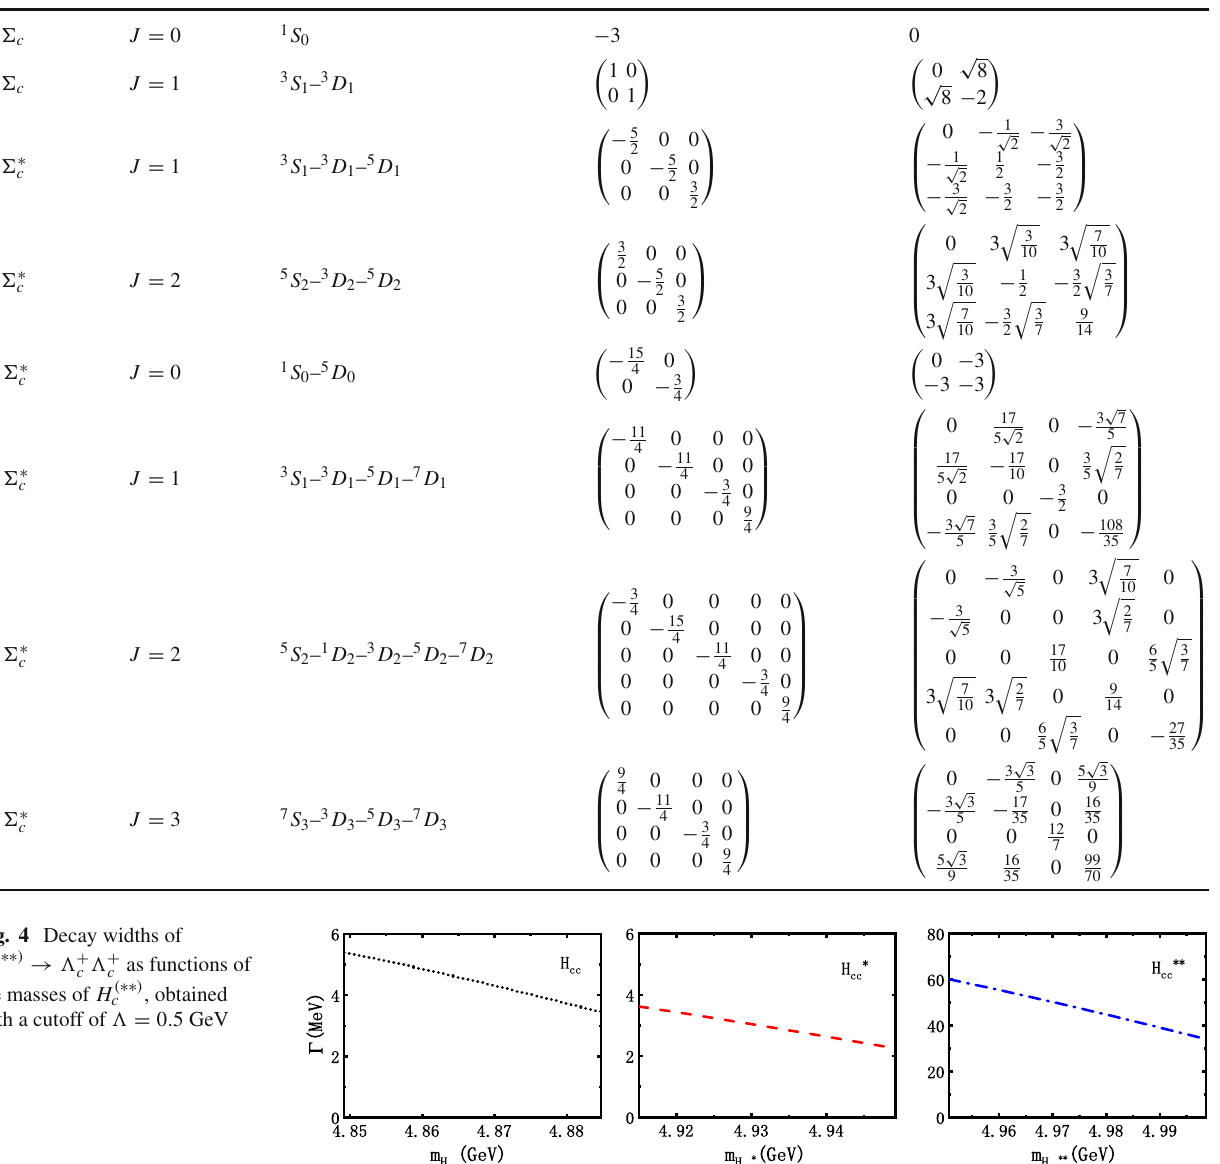
Table 4 Relevant partial wave matrix elements for the (cid:2) ( ∗ ) c (cid:2) ( ∗ ) c system State J P Partial wave